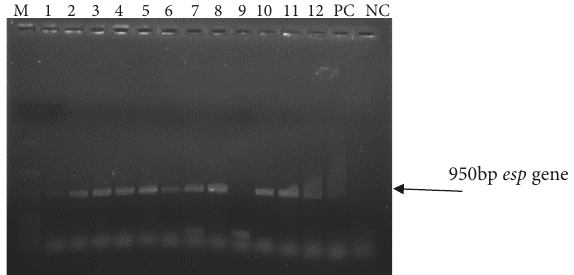
Figure 1: Agarose gel picture of PCR reaction showing Enterococcus spp. positive for esp gene. Lanes: M: molecular weight marker; 1: isolate negative for esp ; 2 to 8: isolates positive for esp ; 9: isolate negativefor esp ; 10 to12: isolates positive for esp ; PC: positive control for esp ; NC: negative control for esp